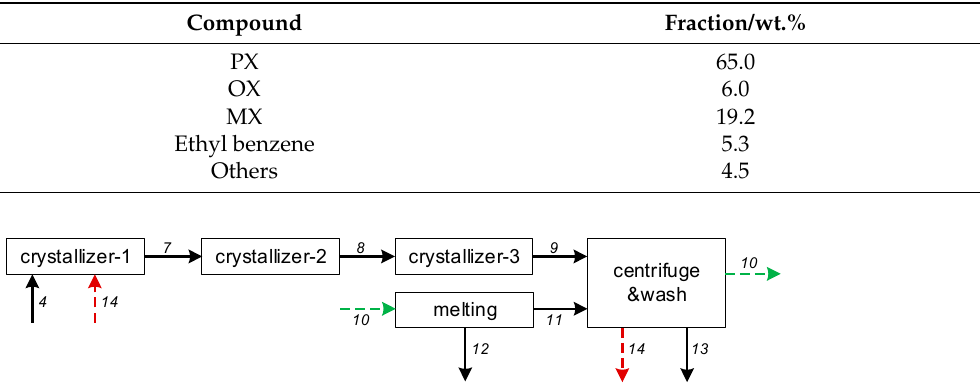
Table 4. The composition of feed introduced to crystallizers in a practical industrial process.